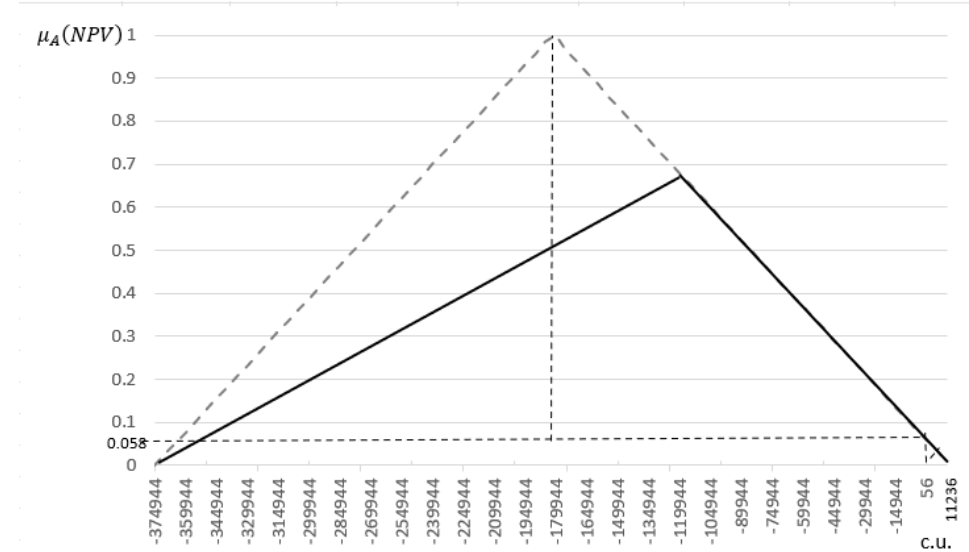
Figure 3. Graph of the membership function of the NPV indicator of an innovative project.